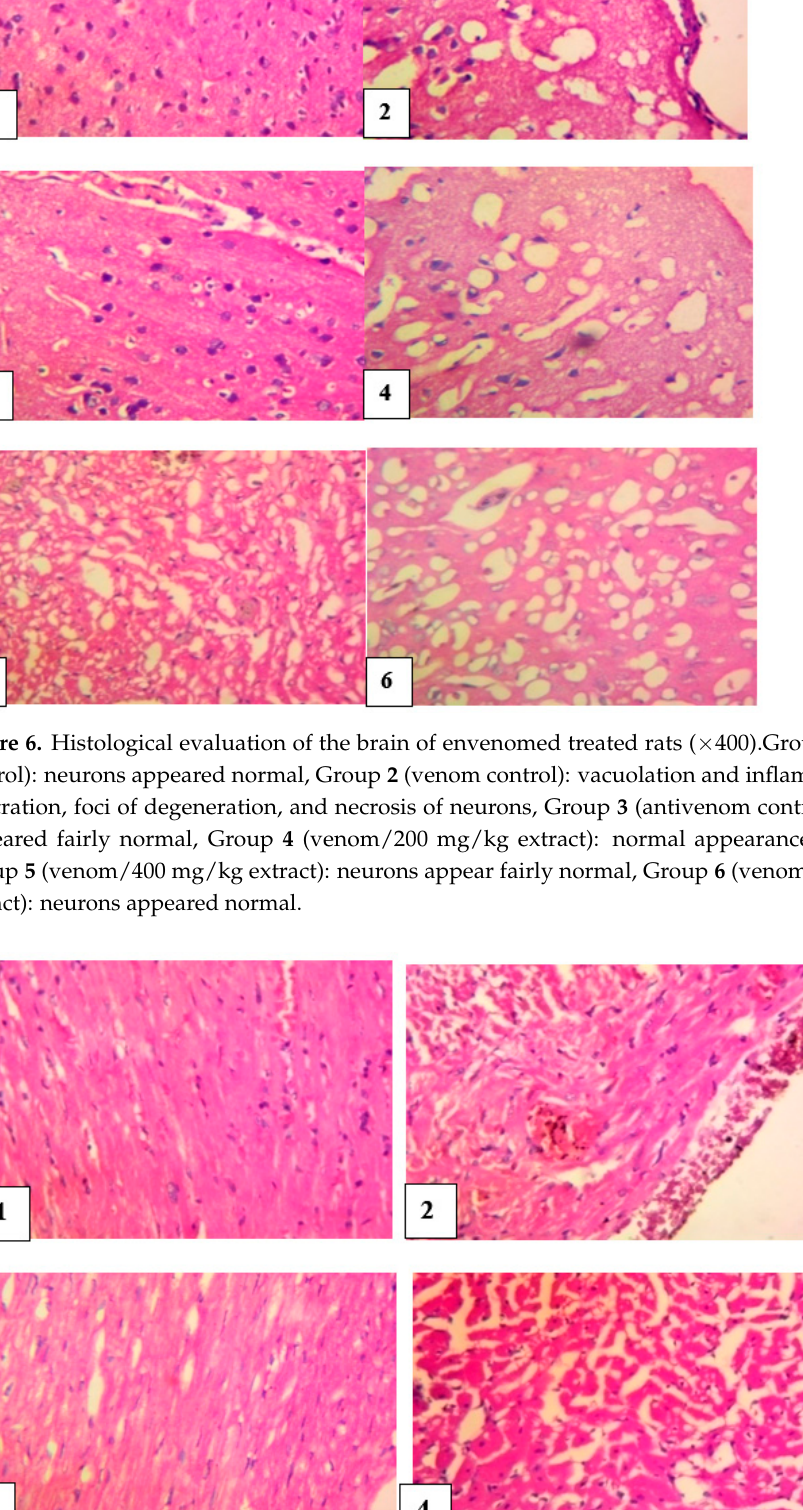
Figure 7. Histological examination of the heart of envenomed treated rats (×400) Group 1 (normal control): cardiomyocytes appeared normal, Group 2 (venom control): multiple foci of thinning and attrition of cardiomyocyte and epicardia hemorrhages, Group 3 (antivenom control): extensive foci of mild pallor of the cardiomyocytes, Group 4 (venom/200 mg/kg extract): focus of the cardiomy- ocytes, Group 5 (venom/400 mg/kg extract): few foci and mild pallor of the cardiomyocytes, Group 6 (venom/600 mg/kg extract):cardiomyocytes appeared normal. 4.9.3. Histopathological Studies of the Kidney The kidneys of control rats showed normal tubules, glomerular capillaries and renal interstitial blood vessels. However, slides of kidneys of untreated envenomed rats re- vealed a local extensive foci of marked flattening of tubular epithelial cells, giving the tubules a cystic dilated appearance. Histological slides of envenomed rats treated with antivenom showed a moderate congestion of glomerular capillary tufts and interstitial blood vessels whereas a local extensive foci of marked flattening epithelium of tubules